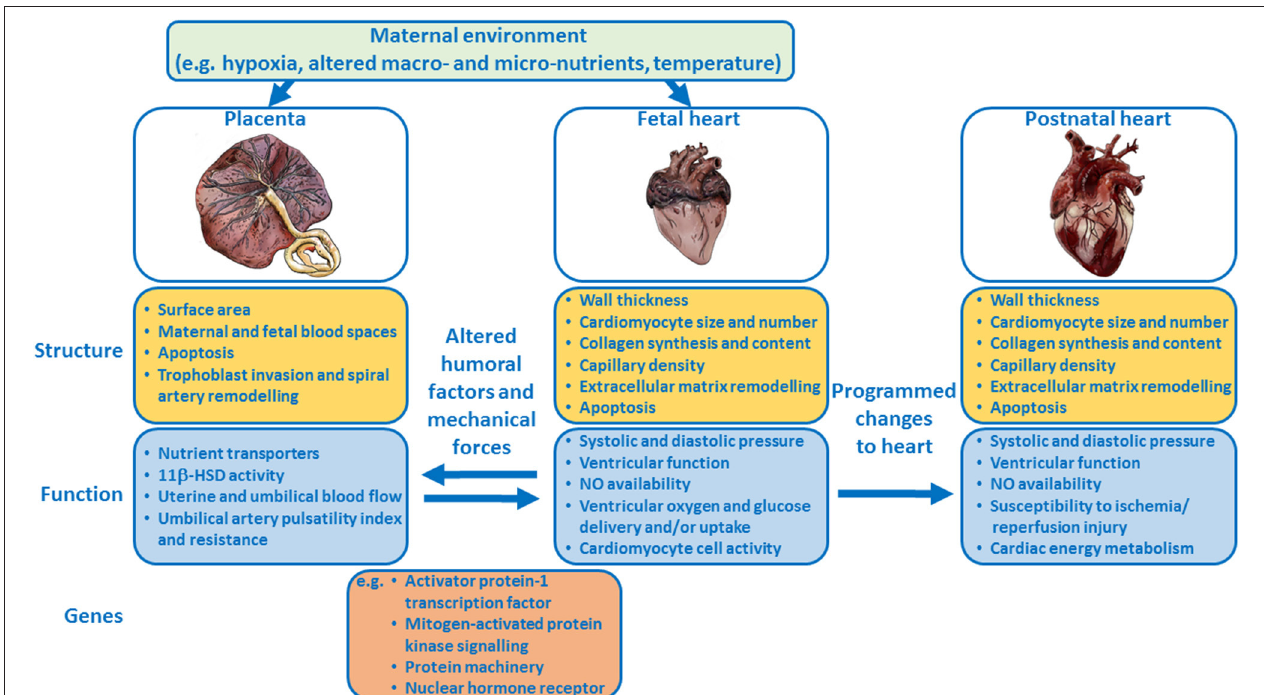
FIGURE 1 | Schematic summary showing how the placenta and fetal heart may influence each other and how the maternal environment may modulate the placenta-fetal heart axis, and the structure and function of both organs. Examples of genes that regulate the development of both the placenta and heart are listed.